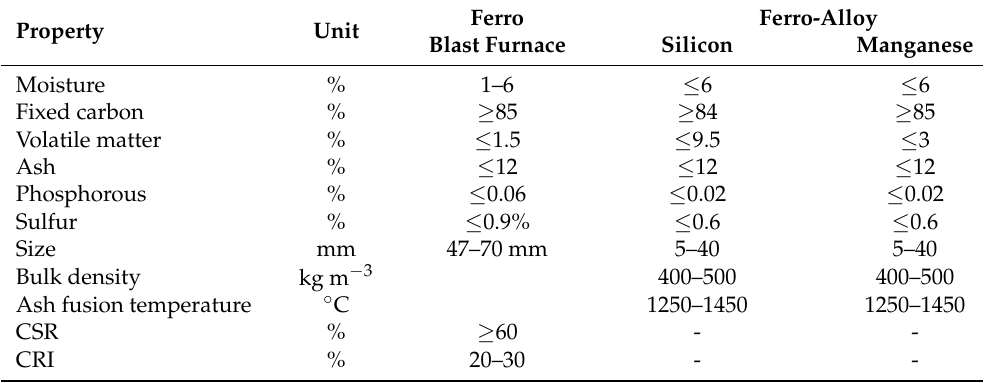
Table 2. Desired properties of carbon reductant in ferro and ferro-alloy industry